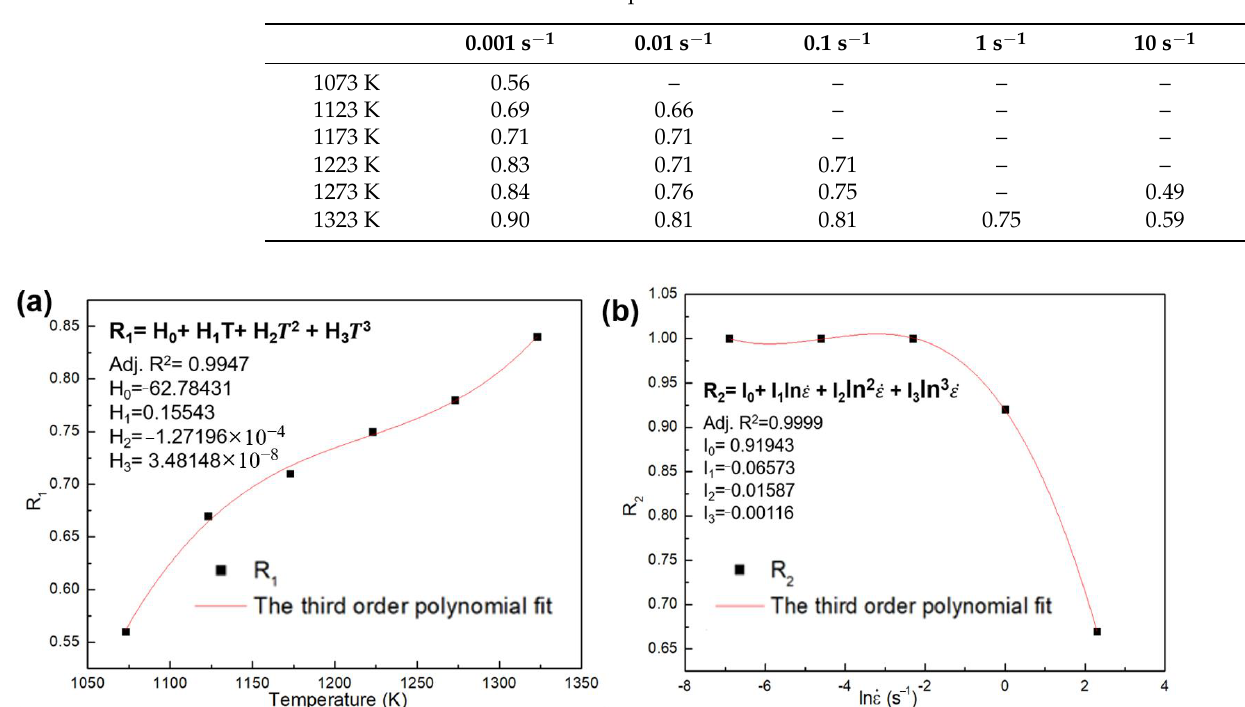
Figure 15. The fitted curves of the ( a ) R 1 and ( b ) R 2 .